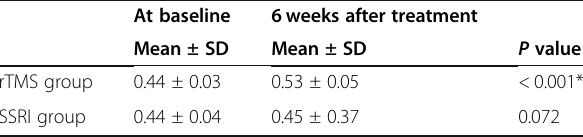
Table 2 Left DLPF white matter FA values at baseline and 6 weeks after receiving rTMS and